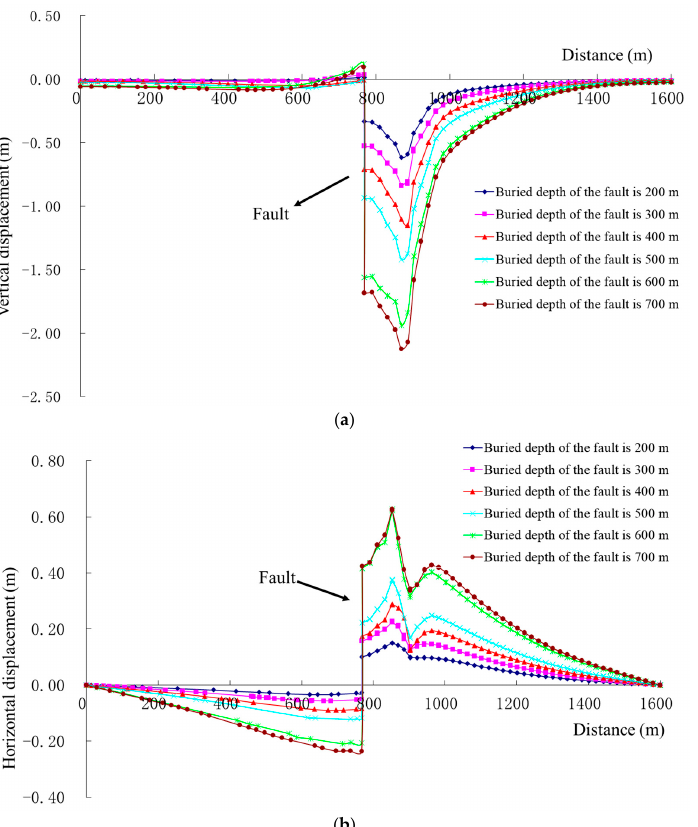
Figure 10. Displacement distribution of surrounding rock of the monitoring line under the condition of different upper boundary buried depths of the fault, they should be listed as: ( a ) Vertical dis- placement distribution; ( b ) Horizontal displacement distribution.